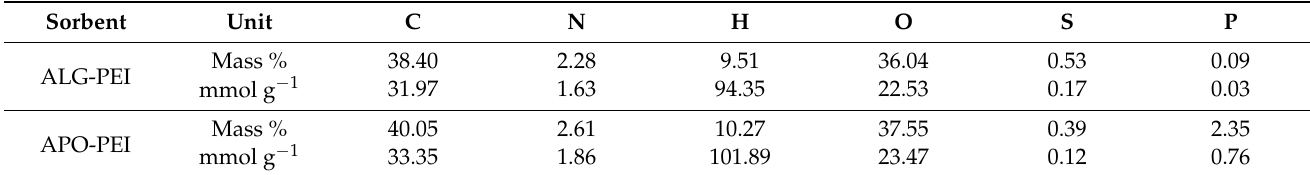
Table A1. Elemental analysis of ALG-PEI and APO-PEI sorbents.